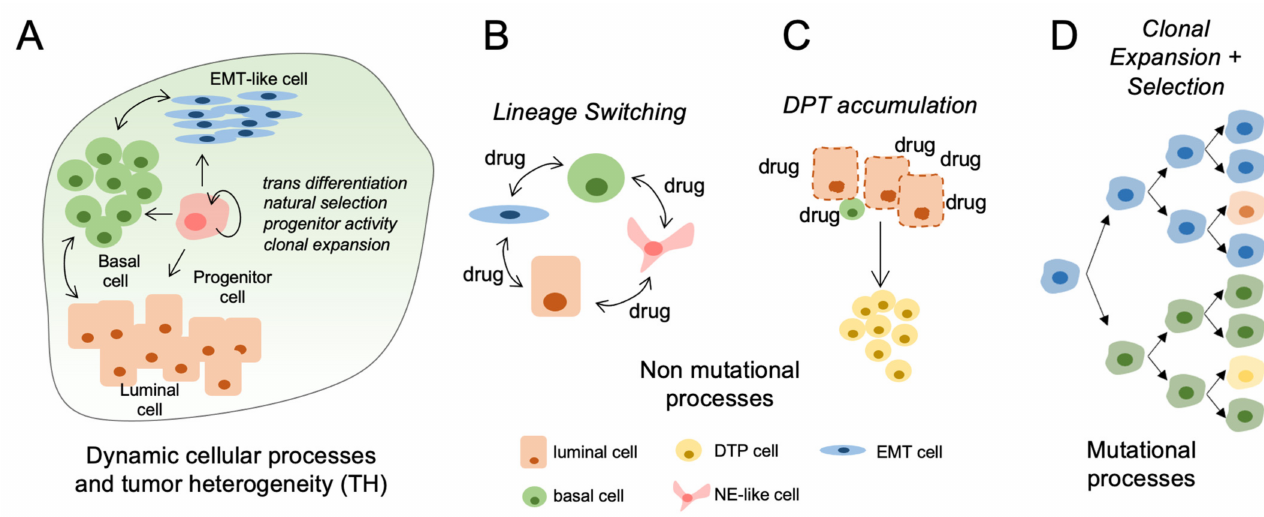
Figure 1. Mechanisms and impact of tumor heterogeneity in clinical bladder cancer progression. ( A ) Pretreated primary bladder tumors are heterogeneous consisting of lineage defined subpopulations with potential to change in relative proportions during progression or treatment. ( B ) Bladder cancer cells can acquire transcriptional and phenotype changes (EMT, NE-like) in response to therapeutic stress. ( C ) Drug tolerant persisters (DTPs) increase in abundance during clinical therapies. This process may be accelerated using drugs at maximum tolerated dosages (MTD). ( D ) Acquired driver mutations can promote the clonal expansion of cell populations having more aggressive progression kinetics and reduced response to